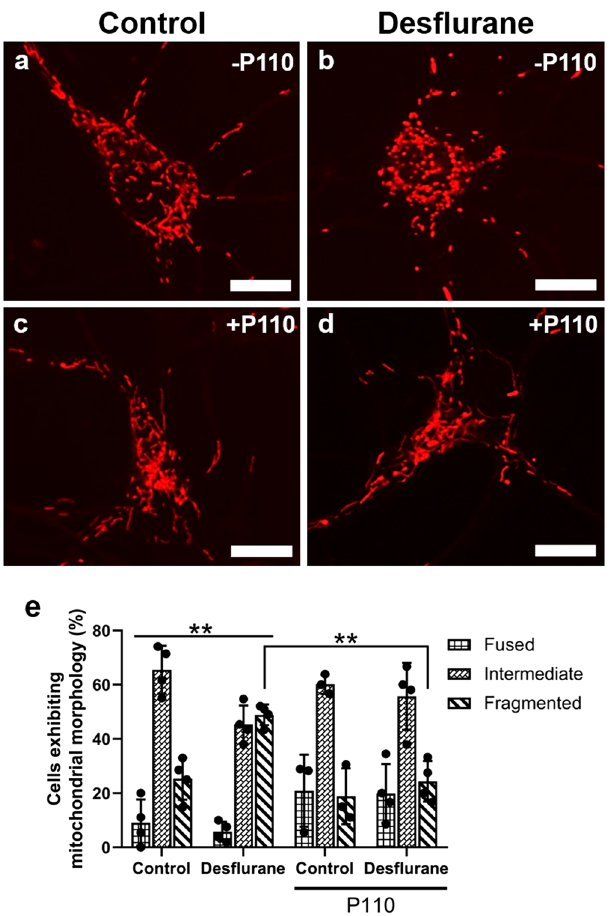
Figure 6. P110 treatment prevents desflurane-induced perturbation of mitochondrial morphology. Fluorescent cropped images showing representative neurons from each condition (a–d) . Quantification of predominant mitochondrial morphology in each treatment (e) . Desflurane alone caused increased fragmentation. P110 alone did not affect mitochondrial morphologies. P110 pre-treatment, followed by desflurane exposure prevented anesthetic-induced aberrations. Two-Way ANOVA. ** p < 0.001 as determined by Tukey’s multiple comparisons post-hoc test. Bars indicate ± SD across biological replicates. Each data-point indicates the percentage of cells that exhibited a specific morphology per biological replicate. Scale bars indicate 10